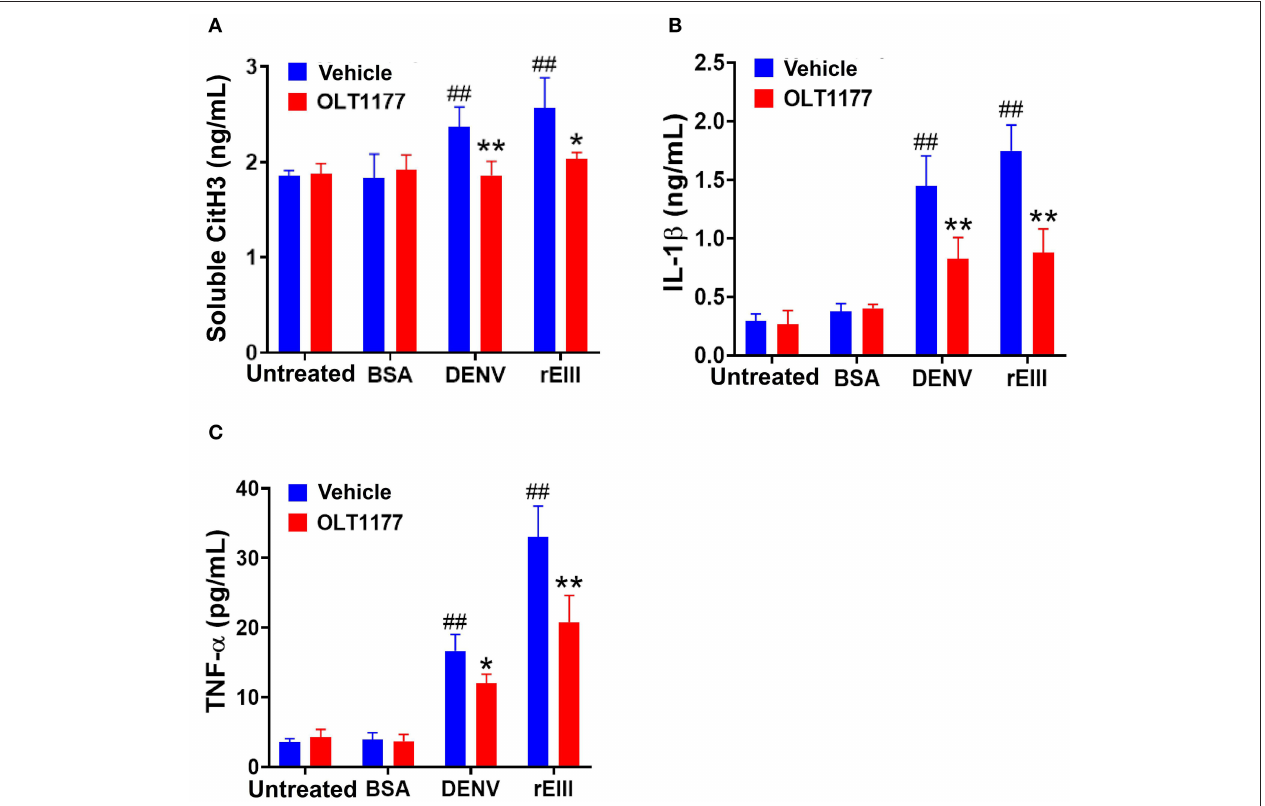
FIGURE 6 | Nlrp3 inhibitor OLT1177 protects mice from DENV- and rEIII-induced NETosis and IL-1 β , TNF- α production in mice. After challenged with vehicle (saline), BSA (a control protein) 2 mg/kg), DENV (1.2 × 10 7 PFU /kg; DHF viral load) and rEIII (2 mg/kg; a dosage equivalent to DENV 1.2 × 10 7 PFU/kg), experimental mice were immediately rescued with or without Nlrp3 inhibitor OLT1177 treatments (50 mg/kg). The ELISA analyzed plasma levels of circulating soluble citrullinated histone H3 (CitH3; a NETosis marker) (A) , circulating IL-1 β levels (B) , and TNF- α levels (C) after 1 d treatments were showed. n = 6, ## P < 0.01, vs. respective untreated groups; * P < 0.05, ** P < 0.01, vs. respective vehicle groups. predominantly displayed in serum samples of DHF patients